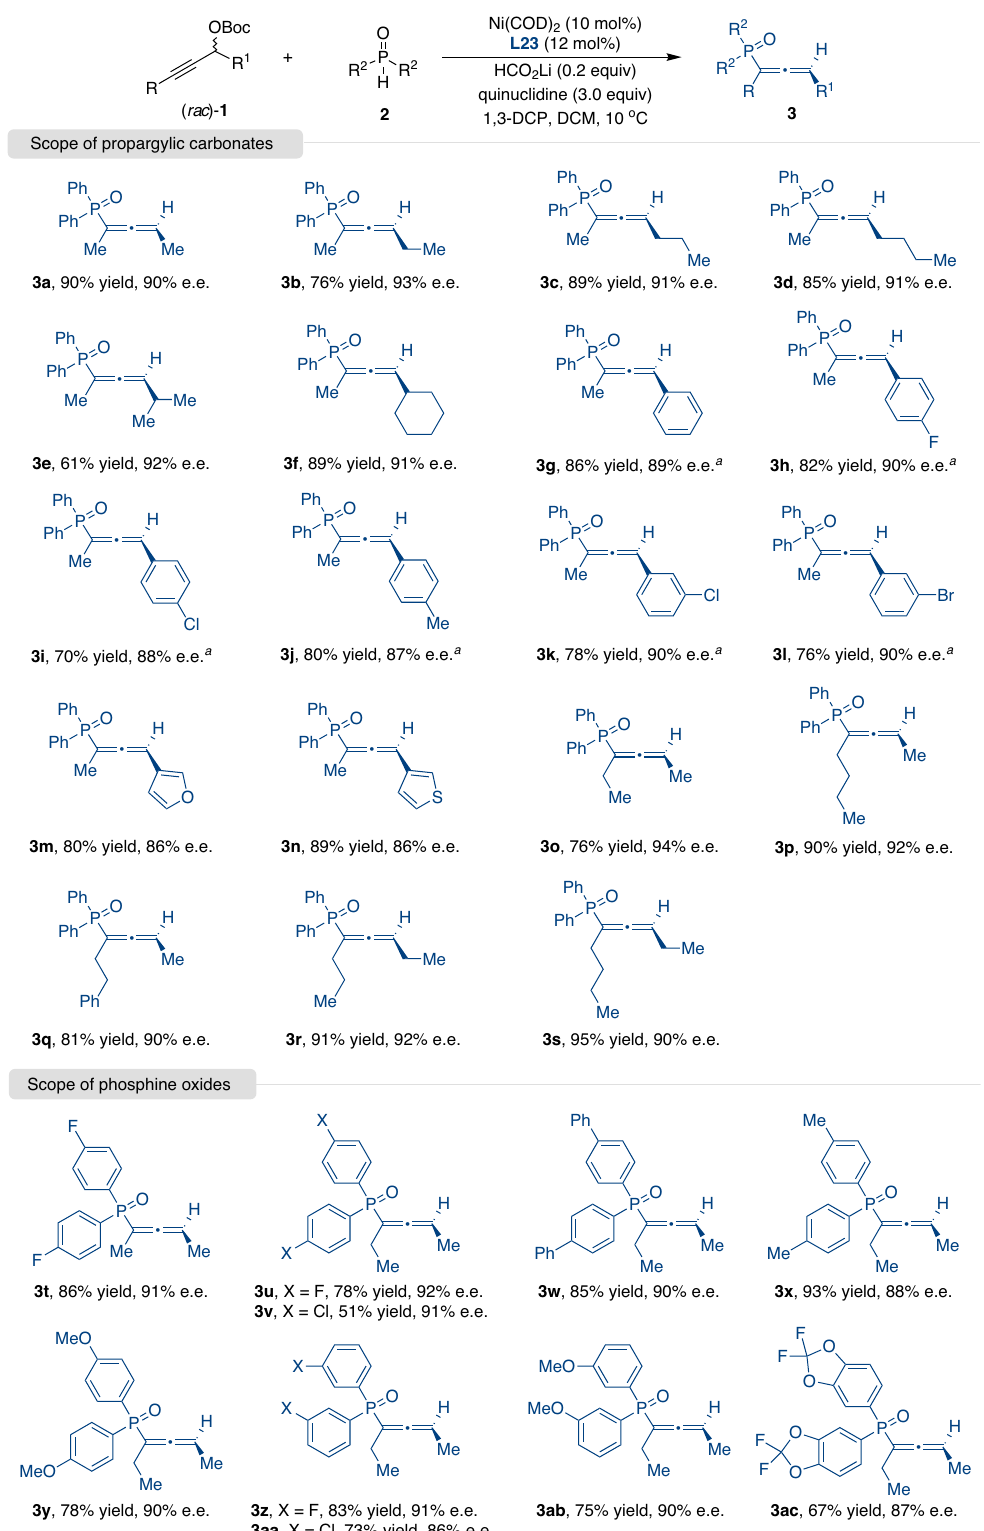
Fig. 3 | Nickel-catalyzed enantioselective allenylation. Reactions were per- formed by using Ni(COD) 2 (10mol%), L23 (12mol%), ( rac )- 1 (0.3mmol), 2 (0.1mmol), HCO 2 Li (0.2 equiv), quinuclidine (3.0 equiv), and 1,3-DCP (30 μ L) in